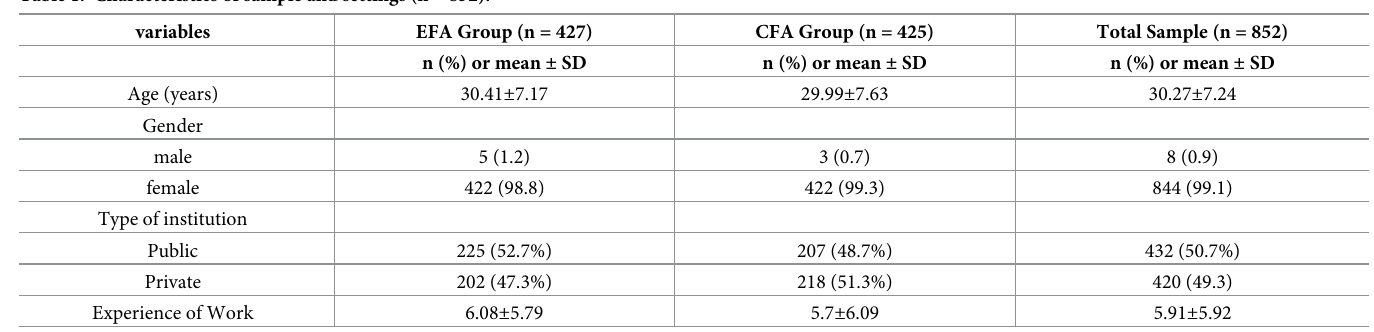
Table 1. Characteristics of sample and settings (n =